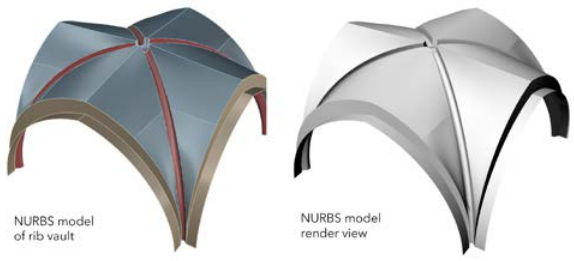
Figure 7. Final NURBS model of the rib